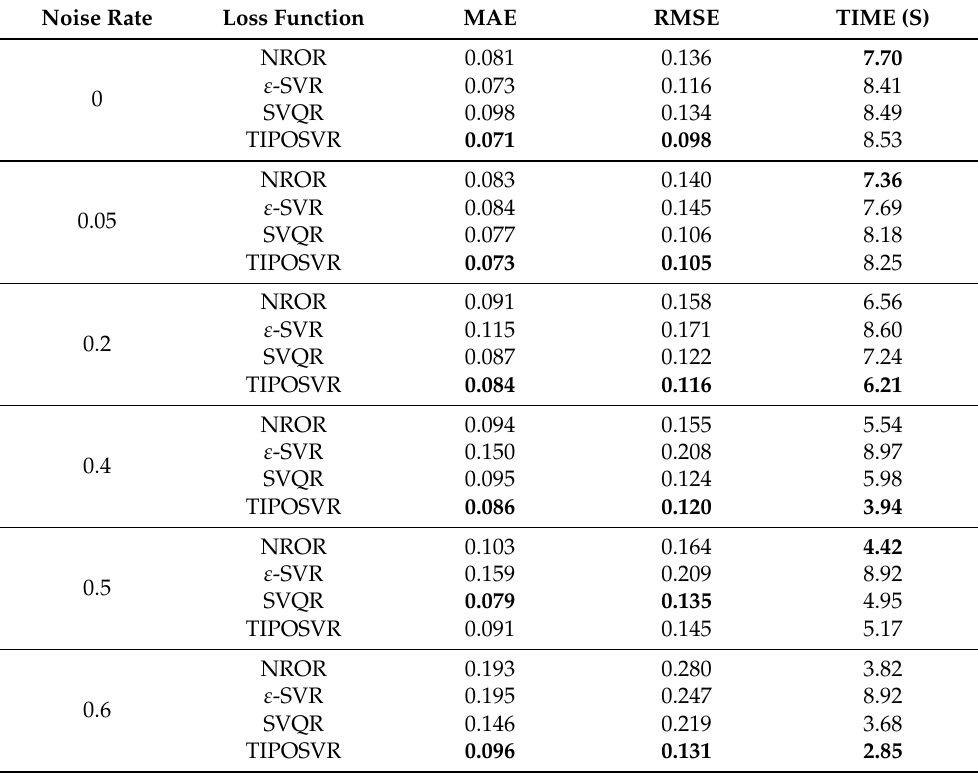
Table 3. Operation results of algorithms under the influence of noise type I for synthetic dataset. Noise Rate Loss